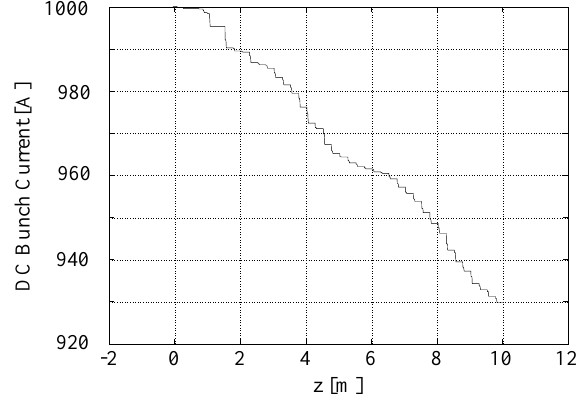
FIG. 5. Microbunch current evolution from matching section through main extraction section.